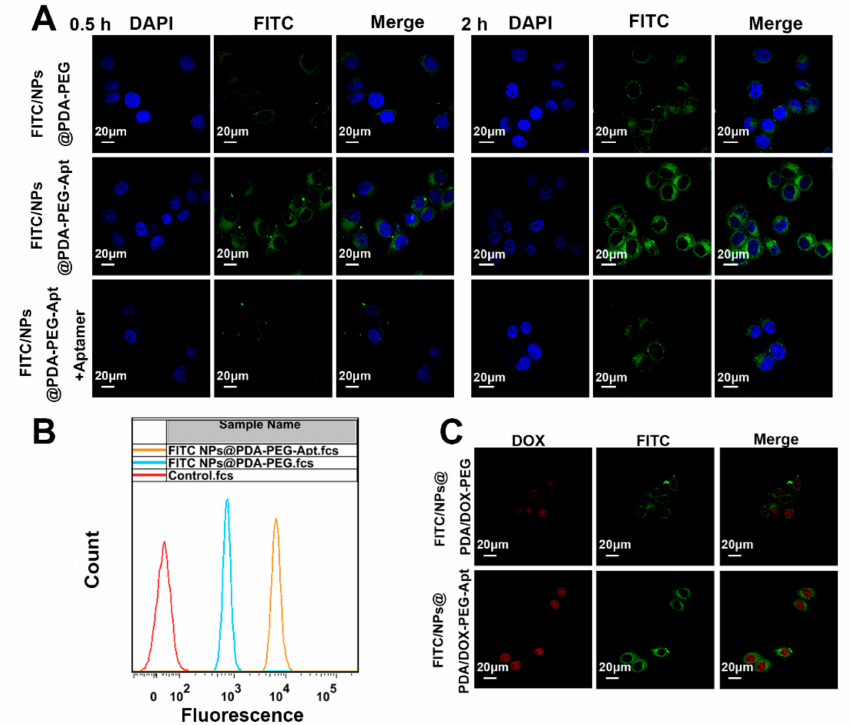
Figure 5. ( A ) Confocal laser scanning microscopy (CLSM) images of MCF-7 cells after incubation with FITC-labeled NPs for 0.5 and 2 h. Green: FITC-labeled NPs, blue: DAPI-stained nucleus, Scale bar: 20 µ m. ( B ) Flow cytometry (FCM) analysis of MCF-7 cells after incubation with FITC-labeled NPs for 1 h. ( C ) CLSM images of MCF-7 cells after incubation with FITC / NPs@PDA / DOX-PEG or FITC / NPs@PDA / DOX-PEG-Apt for 2 h. Green: FITC-labeled NPs, Red: DOX, scale bar = 20 µ